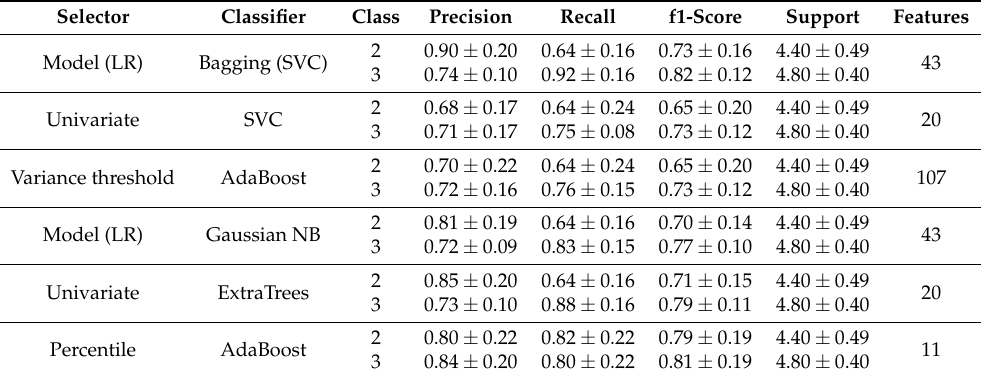
Table 7. Best pipelines’ performance